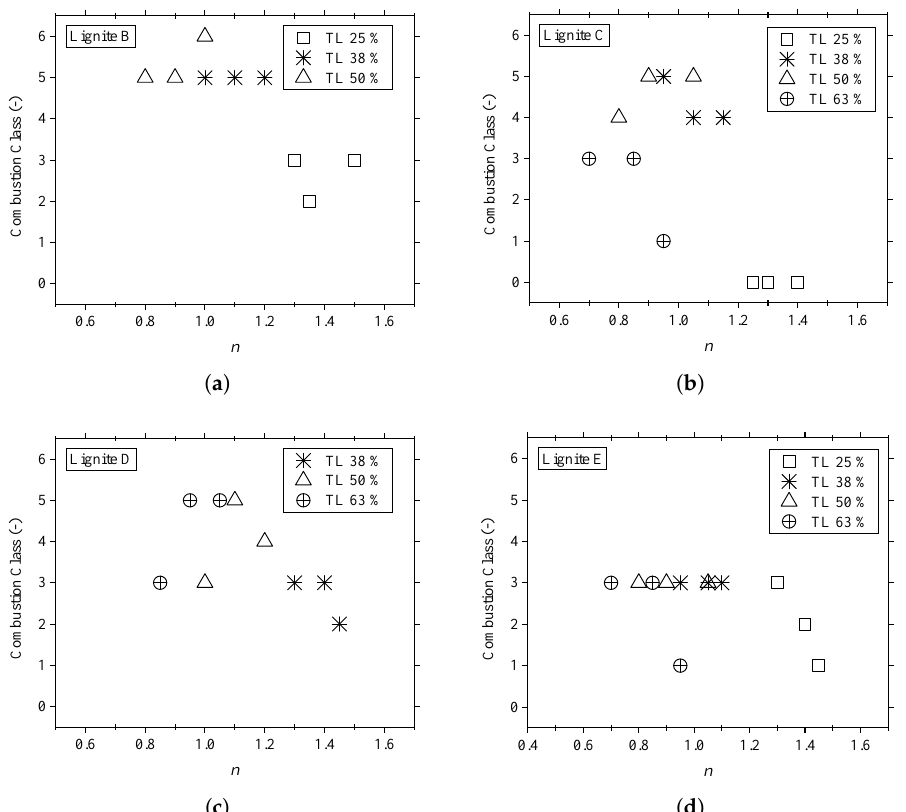
Figure 3. The Combustion Class versus air ratio obtained by four lignite qualities at several thermal loads (TL), ( a ) Lignite B, ( b ) Lignite C, ( c ) Lignite D, ( d ) Lignite